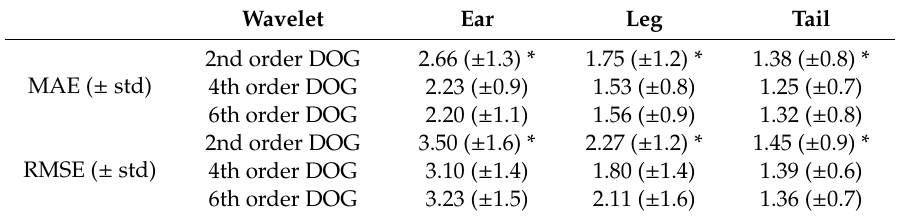
Figure 8. The decoupled cardiac pulse signals using the CWTFT algorithm based on three different orders (m = 2, 4, 6) of DOG wavelet in comparison to one segment of the original raw PPG signal obtained from the ear of the anaesthetised pig. Table 1. The Mean Absolute Error (MAE) and Root Mean Square Error (RMSE) of the estimated heart rate (bpm) from all the PPG segments, in comparison to the reference pulse rate calculated from the ECG signals obtained from the anaesthetised pig. Comparing the estimated heart rate based on three orders (2, 4 and 6) of DOG